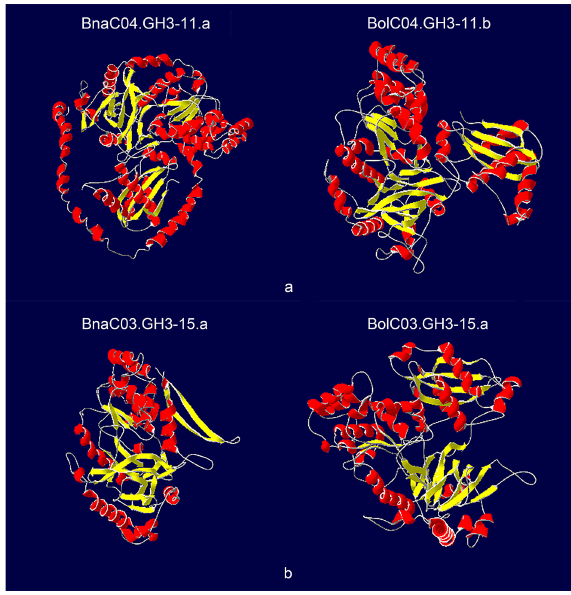
Figure 6. The 3-dimensional structures of BnaC04.GH3-11.a/BolC04.GH3-11.b and BnaC03.GH3- 15.a/BolC03.GH3-15.a. The α -helices, β -strands, and random coils were colored by red, yellow, and grey,